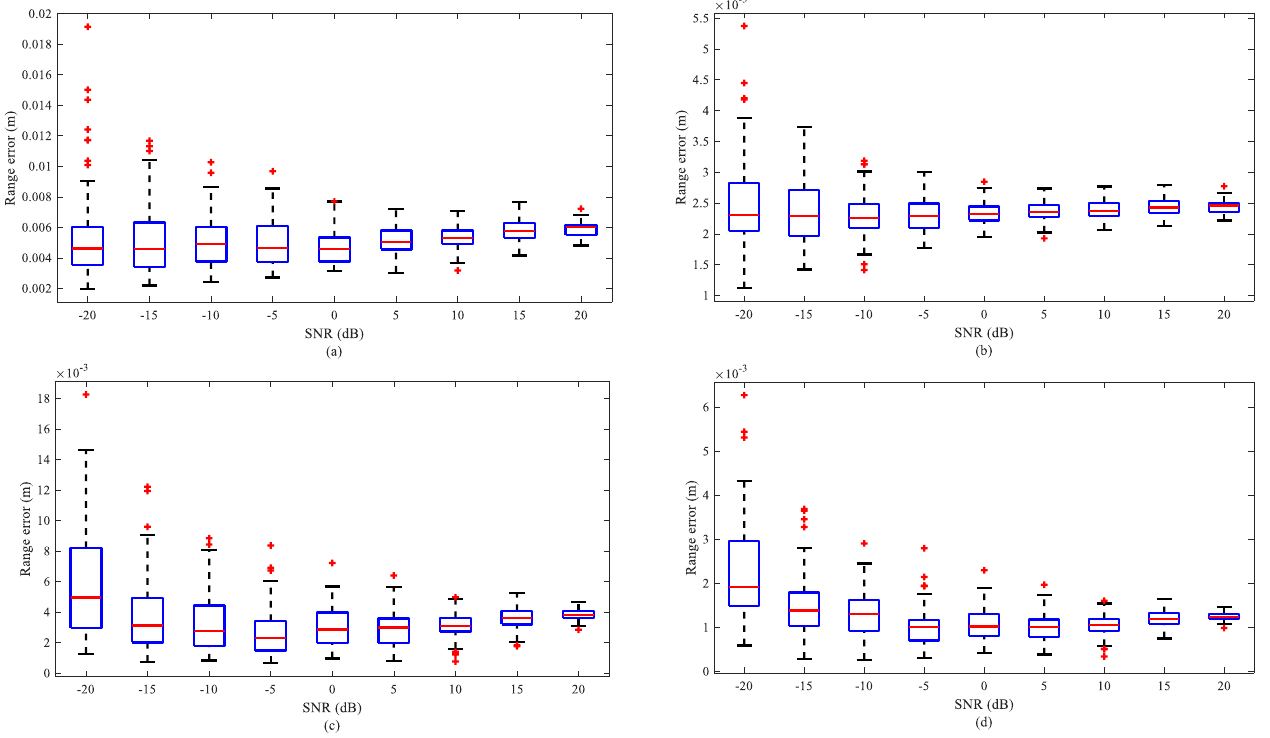
Figure 12. Relative range estimation accuracy versus different SNRs. ( a ) The maximum KF errors in ideal state. ( b ) The average KF errors in ideal state. ( c ) The maximum KF errors in the presence of echo blockages. ( d ) The average KF errors in the presence of echo